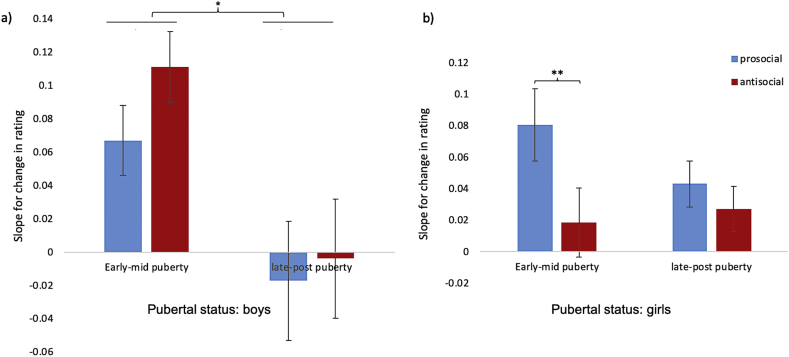
The slope for change in rating by pubertal status for boys (a) and girls (b). The Y-axis shows the slopes for the average change in ratings (difference between rating 1 and rating 2) predicted by the difference between the provided rating and the first rating (Δrating). The slopes were calculated using estimates of the linear mixed-effect models. Error bars represent standard error (**p < .005, *p < .05 Bonferroni-corrected).